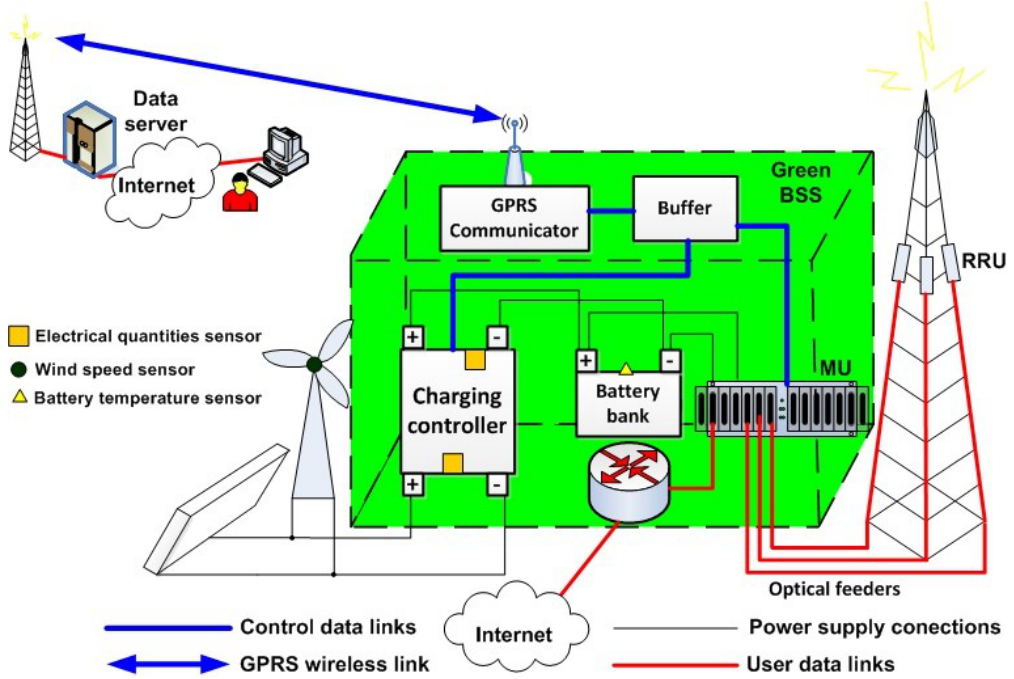
Figure 2. Blok diagram of green BSS architecture with centralized monitoring system.